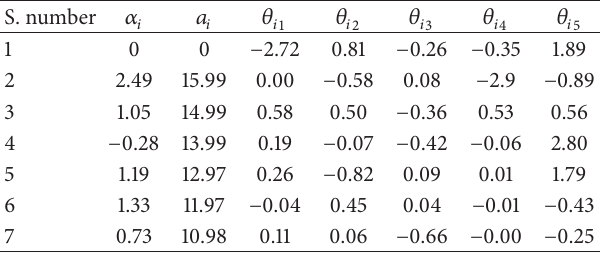
Table 4: Seven-link manipulator design for server room environ- ment.